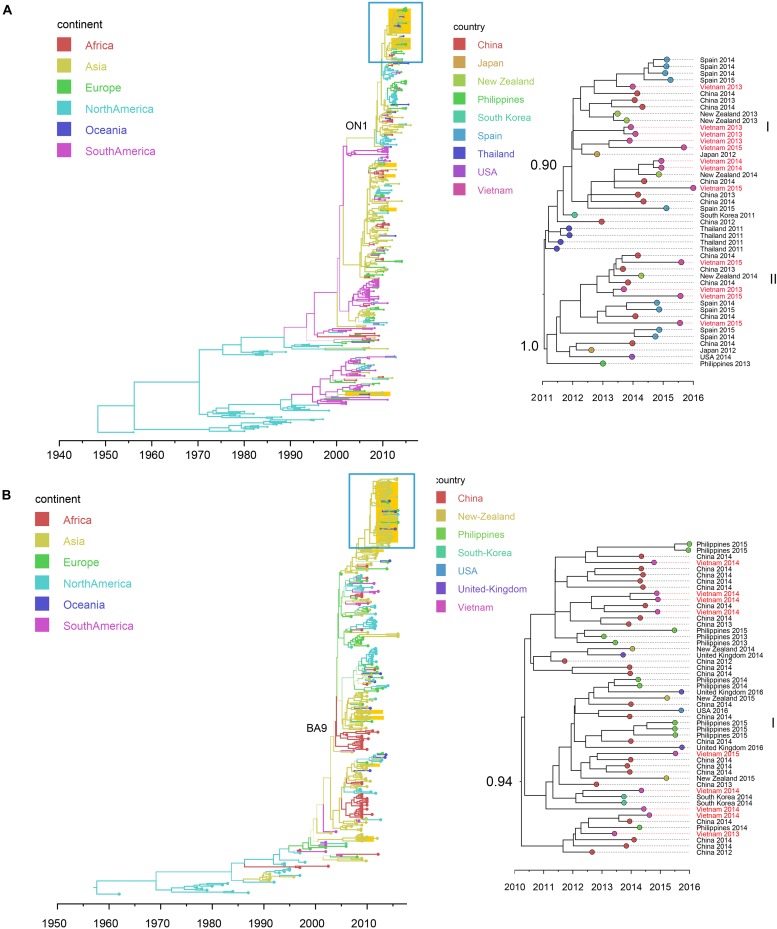
Bayesian maximum clade credibility (MCC) trees of RSV (using G gene sequences) in Vietnam and worldwide: (A) RSV-A (n = 392); (B) RSV-B (n = 314). Branch colors represent the most probable ancestral locations of each branch, inferred using a discrete trait model; sequences from Vietnam (all available) were highlighted in orange. The clades of genotype ON1 in RSV-A and genotype GA-9 in RSV-B were labeled. The clades containing Vietnamese sequences isolated in this study (within the box) are shown on the right, with tip nodes mapped to countries and isolate time (year), with Vietnamese strains highlighted in red, and labeled with subgroups and posterior support.